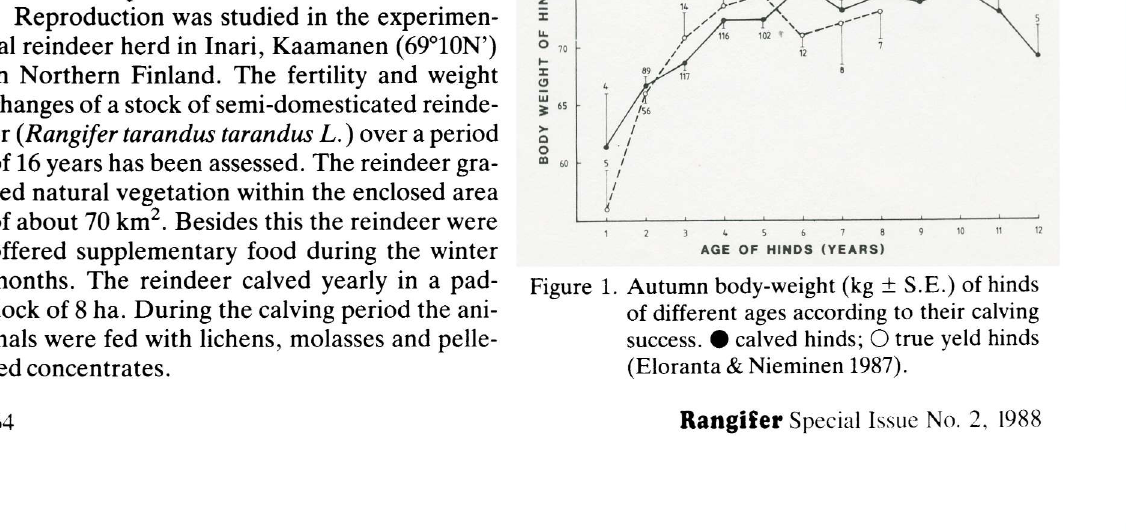
Figure 1. Autumn body-weight (kg ± S.E.) of hinds of different ages according to their calving success. • calved hinds; O true yeld hinds (Eloranta & Nieminen